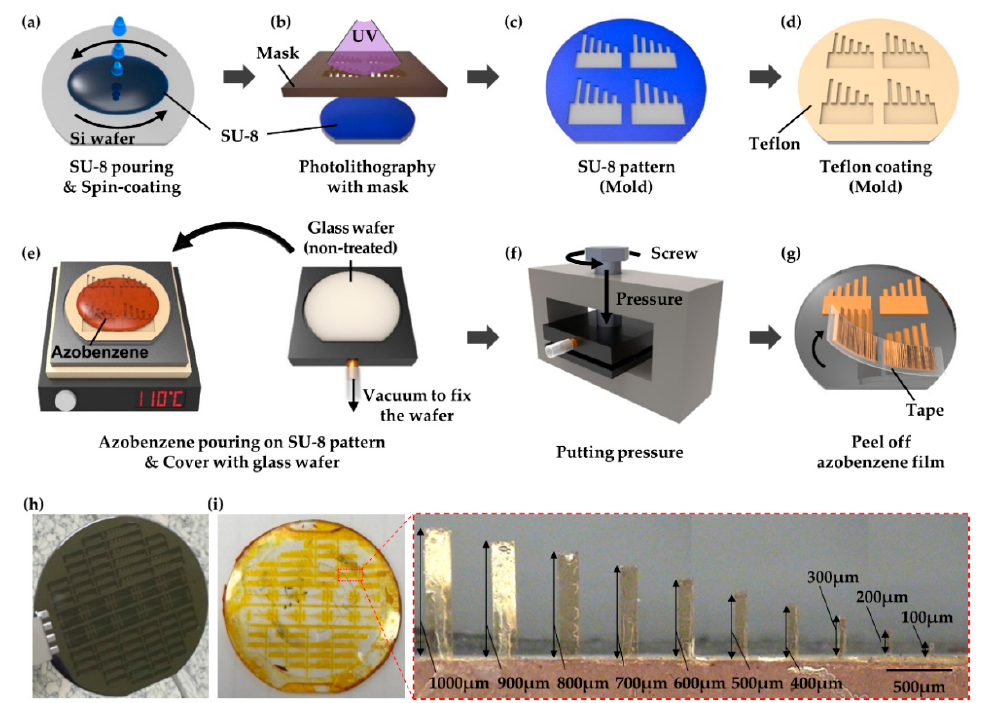
Figure 2. Fabrication process of tazobenzene actuators: ( a – d ) micron-sized mold with microelectromechanical system process, ( e , f ) monomer pouring and polymerization, and ( g ) actuator detachment. Fabrication results of ( h ) the mold on a silicon wafer and ( i ) the polymer actuators. The red box presents an image of the micro-actuators.